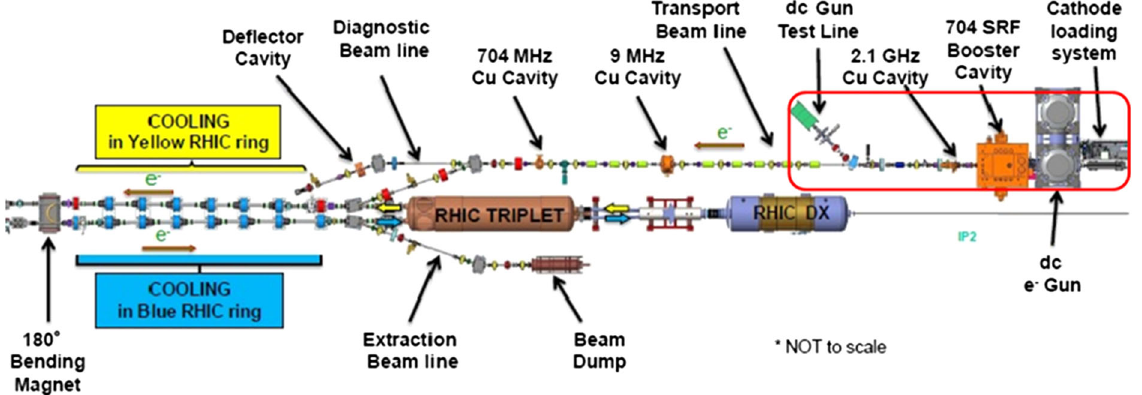
FIG. 1. Layout of the LEReC accelerator.